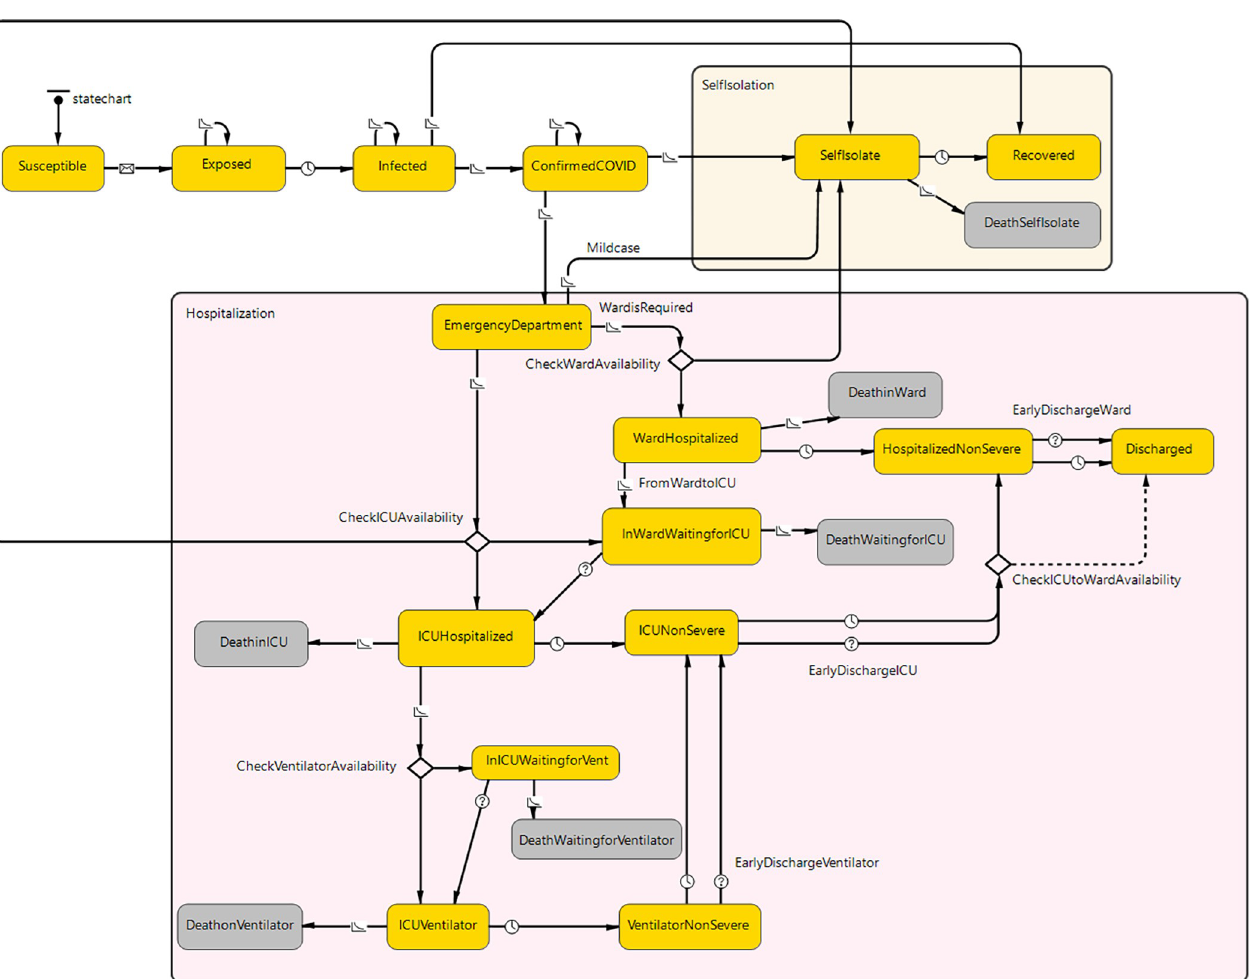
Fig 1. Flow diagram of the disease dynamics and the in-hospital flow of COVID-19 patient in AnyLogic.